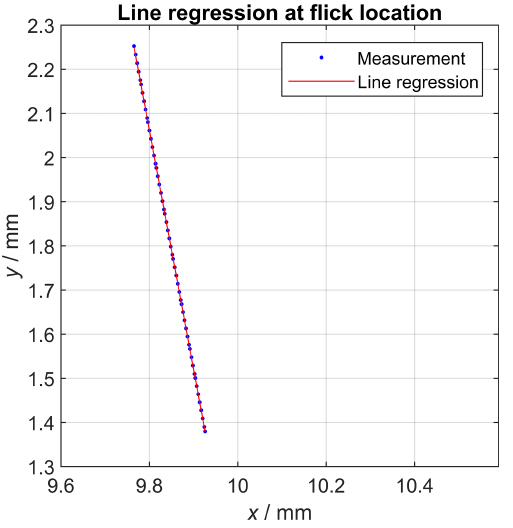
Figure 9. Circle scan containing the flick (height 15µm): distances from the Gaussian circle in polar coordinates. See also coordinates in Fig. 10, with e x matching the vector [ φ = 0 ◦ 1 ] and e y matching the vector [ φ = 90° 1 ] .